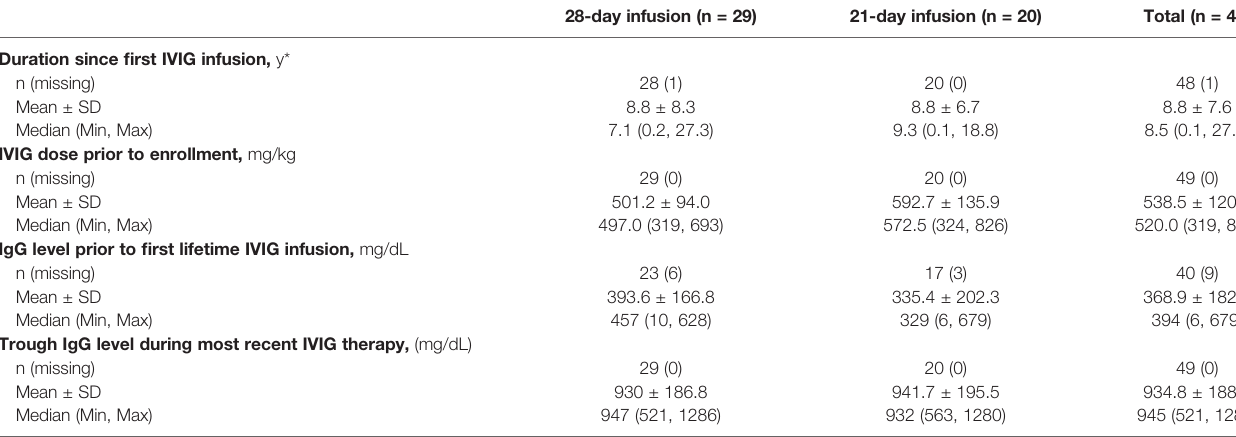
TABLE 2 | Subject history of IVIG therapy at baseline.